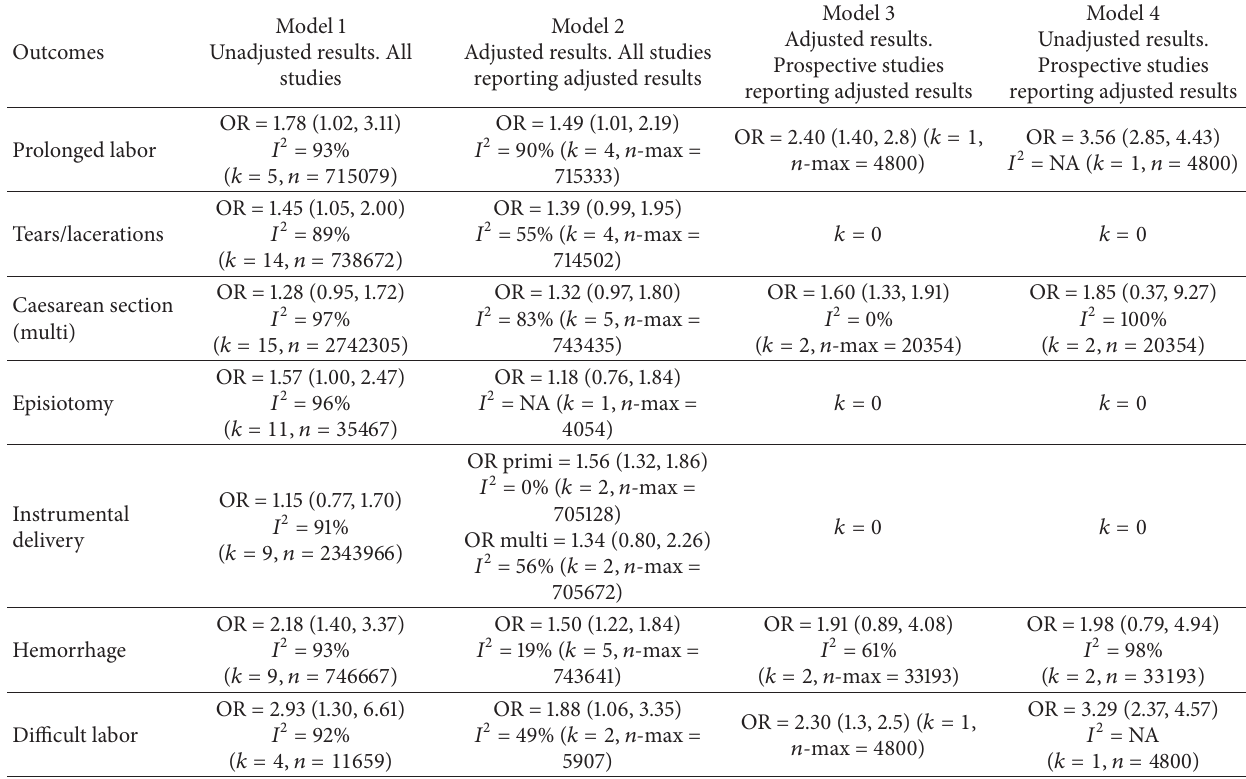
Table 1: Meta-analyses